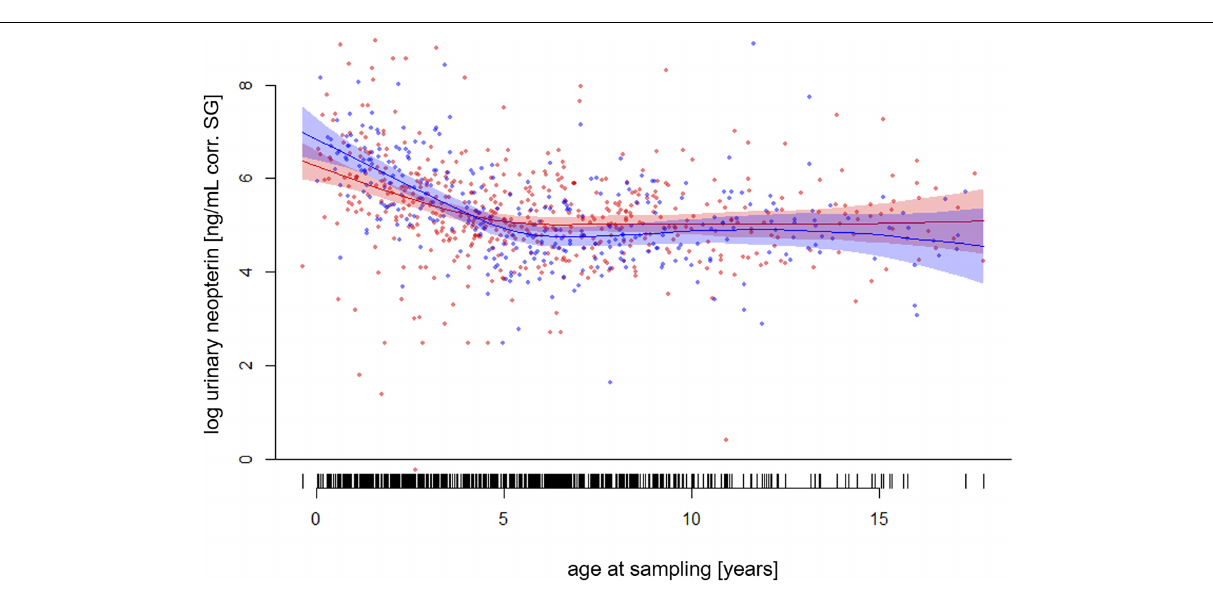
FIGURE 2 | Log-transformed urinary neopterin levels corrected for specific gravity (corr. SG) obtained from wild and zoo-housed female (red) and male (blue) bonobos in relation to chronological age at sampling. Each filled circle and vertical black line at the buttom represents a sample. Lines represent the fitted model for the data set. Shaded areas represent bootstrapped 95% confidence intervals for expected urinary neopterin levels. Total N = 806 urine samples, N female = 495 samples, N male = 311